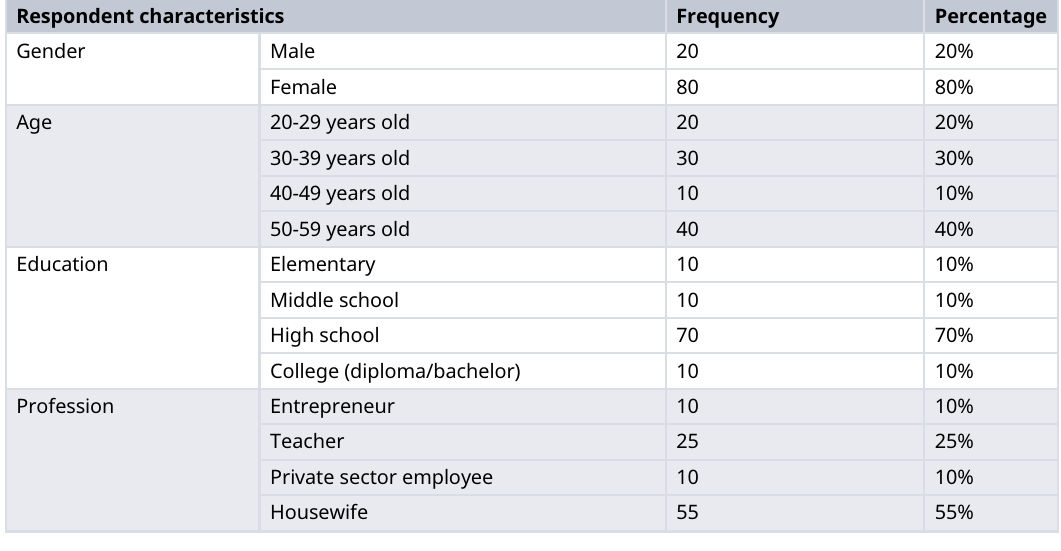
Table 1. Gender, age, education, and profession of study participants.